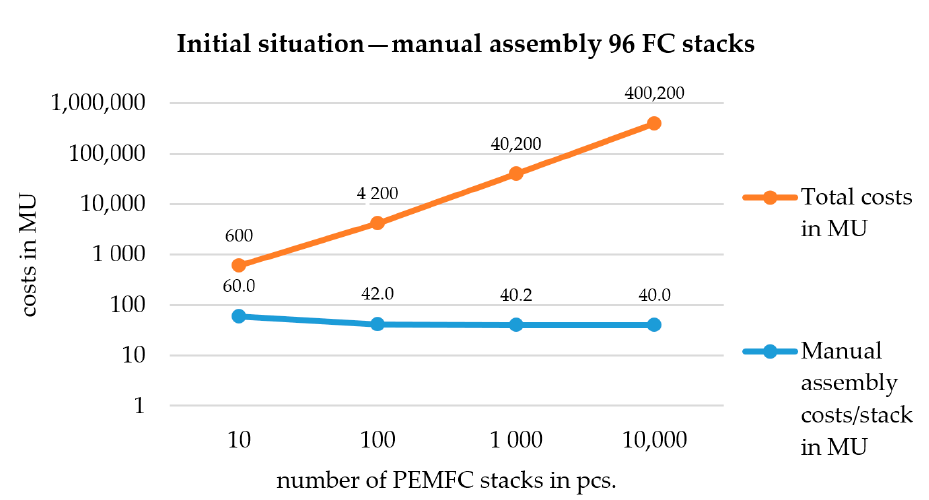
Table 3. Developed MMM—automated assembly of the “modular system seven-layer MEA”— production time 10 min/stack with one operator.